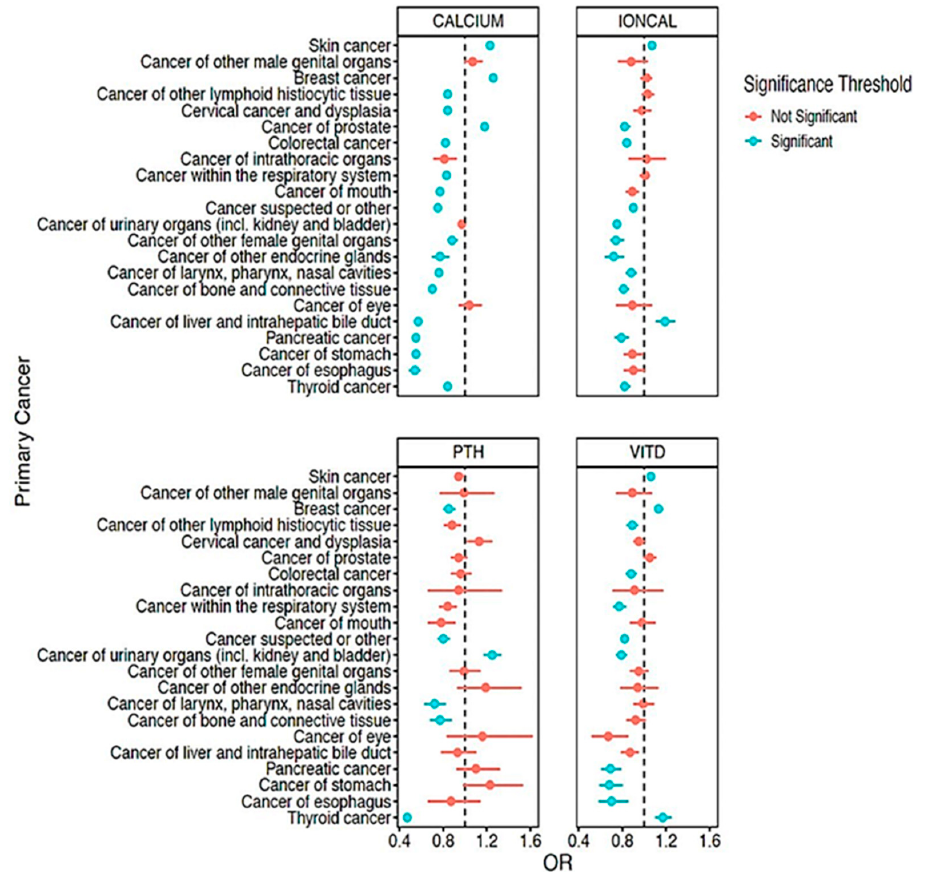
Figure 1. Association of circulating calcium, parathyroid hormone, and vitamin D levels with cancer risk. Forest plots showing the odds associated with circulating levels of the indicated laboratory values and diagnosis of cancer at the indicated pathologic sites. The dashed line in each plot represents an odds ratio (OR) of 1. PTH = intact parathyroid hormone, VITD = vitamin D, IONCAL = ionized calcium.